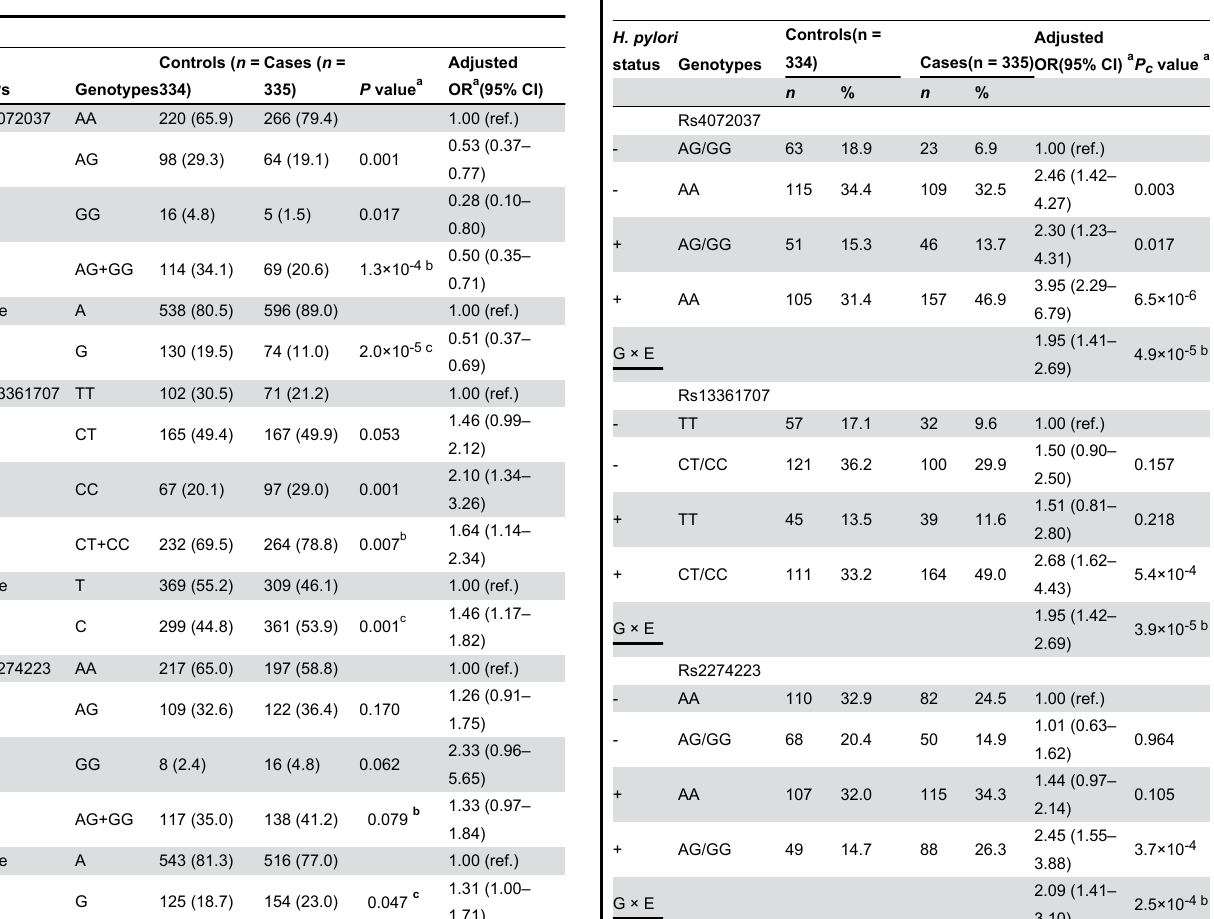
Table 3. Joint effects of H. pylori seropositivity and variants of the three SNPs on risk of